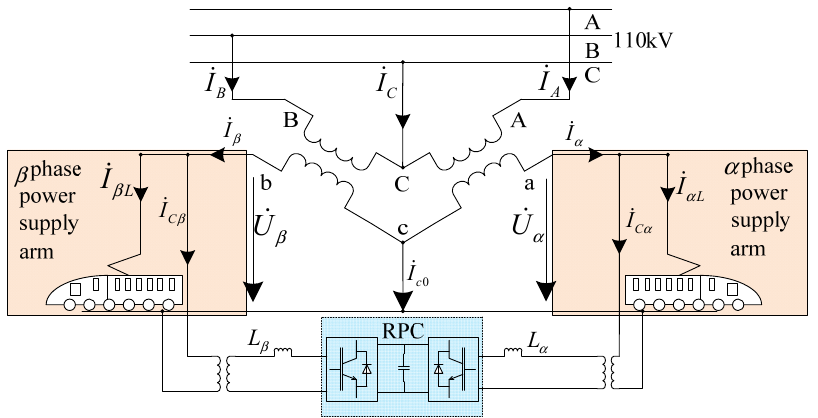
Figure 1. Traction power system with a three-phase V/v transformer and a railway static power conditioners conditioners (RPC).